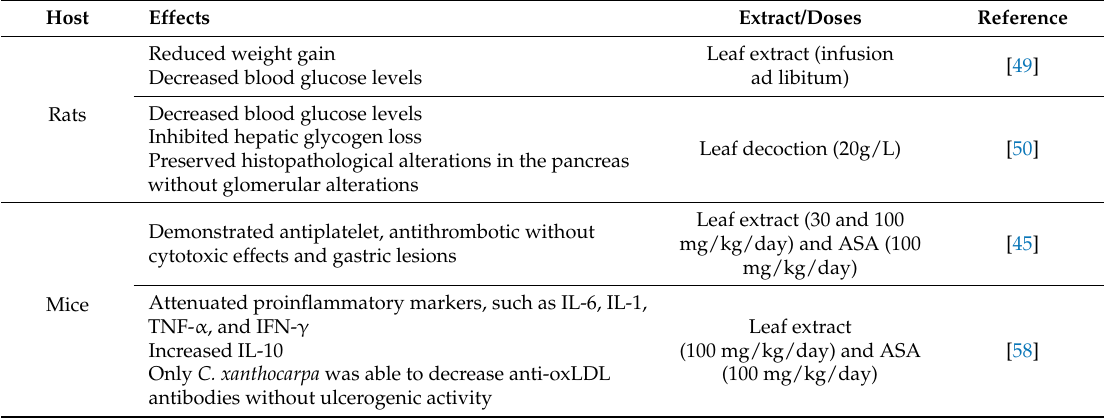
Table 1. Principal effects of C. xanthocarpa in metabolic